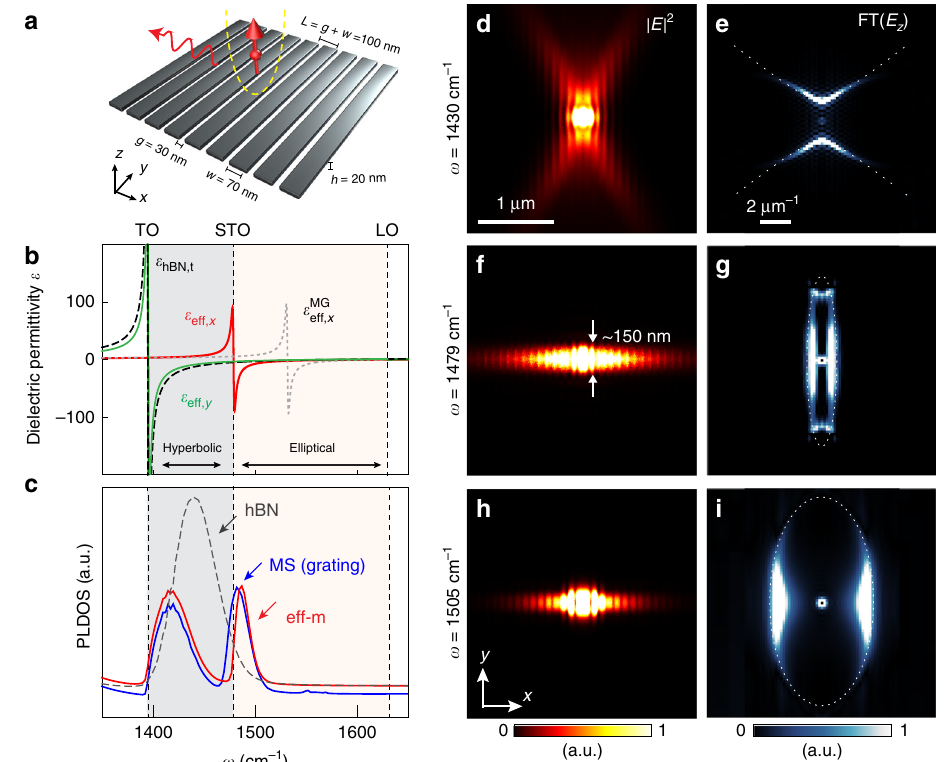
Fig. 1 Topological transition and canalization of polaritons in a hBN metasurface. a Schematic of a 20-nm-thick hBN metasurface based on a grating made of nanoribbons. b Anisotropic effective dielectric permittivities (real parts) of the metasurface calculated using Eqs. 1 – 3, ε eff, x (red line) and ε eff, y (green). Permittivity of unpatterned hBN ( ε hBN, t , dashed black line) and effective permittivity of the metasurface based on Maxwell – Garnett approximation ( ε MG , dashed gray line) are provided for comparison. c Simulated PLDOS on the grating metasurface (MS), the effective medium (eff-m) and the eff ; x unpatterned hBN, respectively. d , f , h Near- fi eld intensity distribution of dipole-launched polaritons at three different frequencies. e , g , i Absolute value of the Fourier transform (FT) of the simulated near- fi eld distribution E z (see Supplementary Fig. 4). Dotted hyperbola and ellipses are guides to the